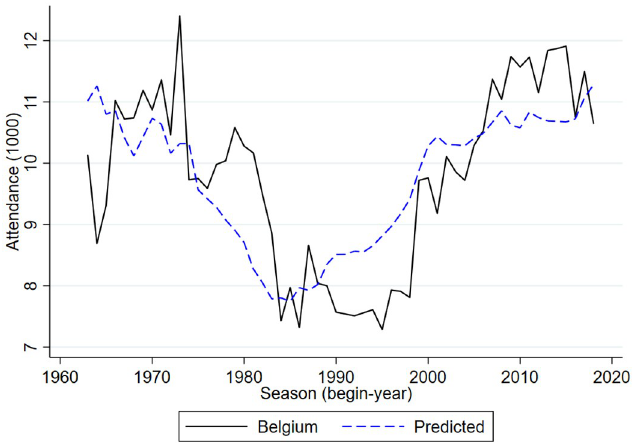
Fig 8. Stadium attendance professional football Belgium; actual and predicted attendance; 1963/64-2018/19